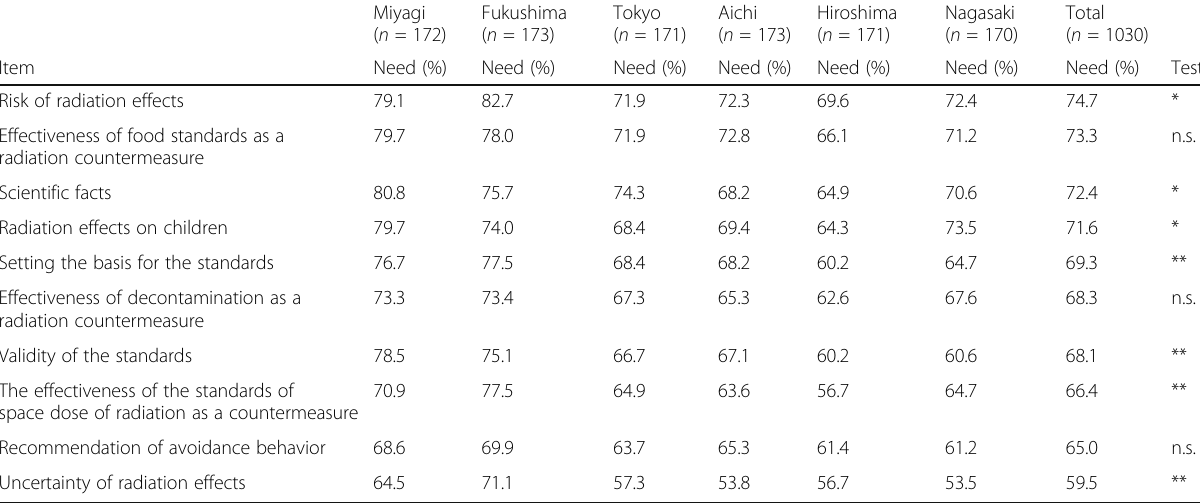
Table 7 Difference in the percentage of “ Need ” on the knowledge which should be delivered at the forum-style risk communication among residents of the six prefectures